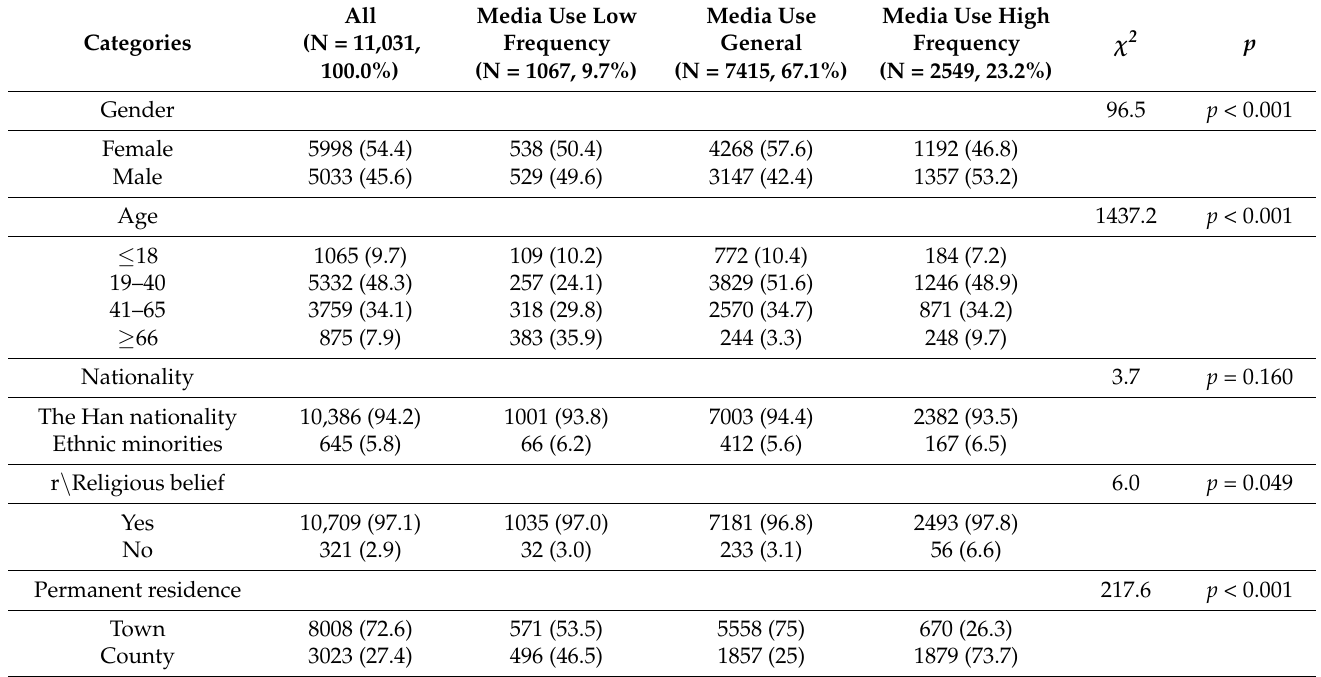
Table 2. Univariate analysis of Chinese residents’ media